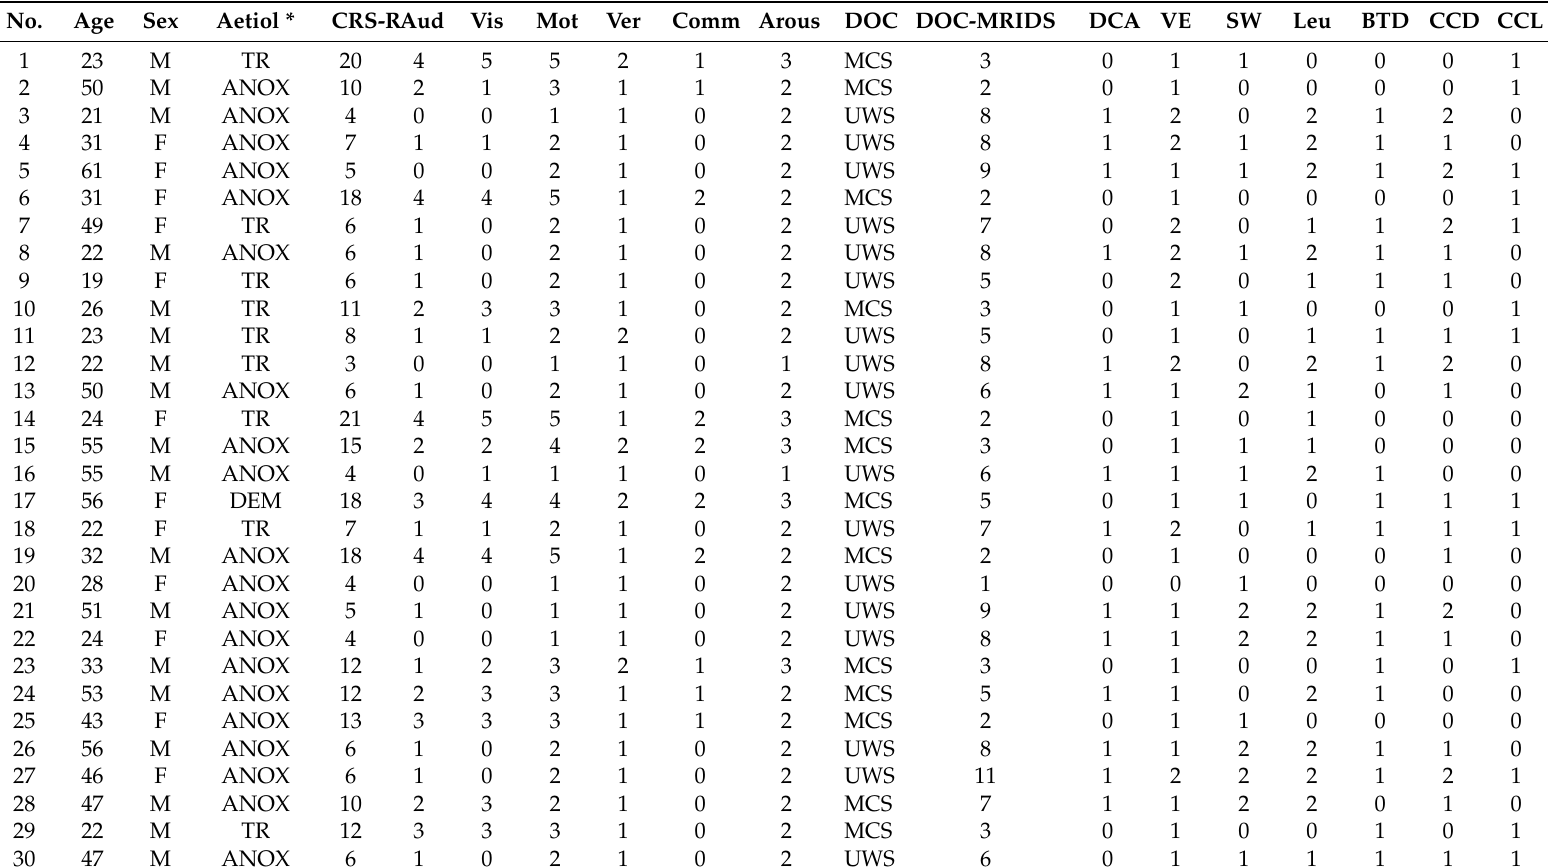
Table 2. Demographic data, CRS-R and DOC-MRIDS total and detailed scores for each